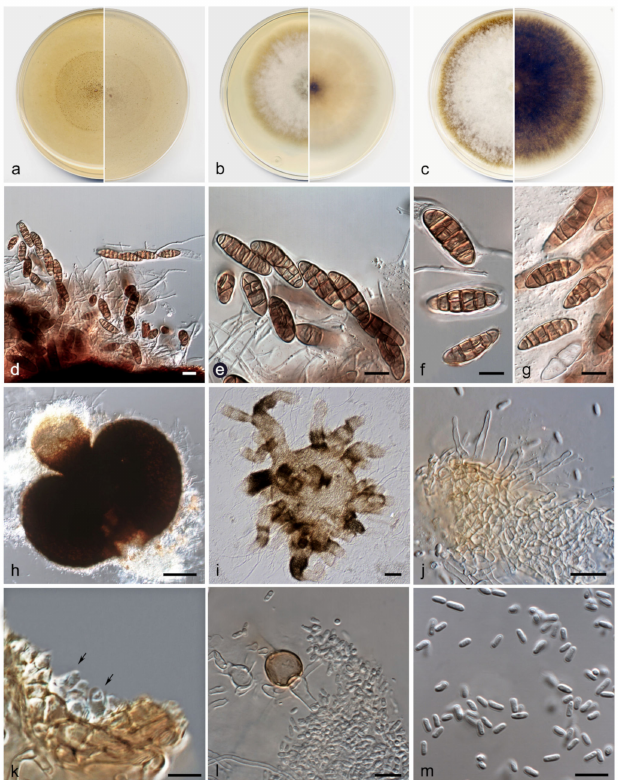
Figure 4. Heterophoma polypusiformis FMR 17837: ( a ) colonies on OA; ( b ) MEA; and ( c ) PDA after two weeks at 25 ± 1 ◦ C (surface, left; reverse, right); ( d , e ) asci and ascospores; ( f , g ) ascospores (note the mucilaginous sheath in ( f )); ( h , i ) pycnidium; ( j ) setae; ( k ) conidiogenous cells (black arrows); ( l ) chlamydospores and conidia; ( m ) conidia. Scale bars: ( h , i ) = 50 µ m; ( d – g ), ( j – m ) = 10 µ